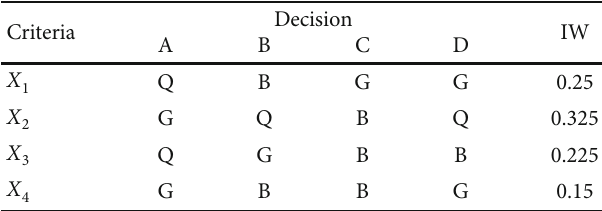
Table 4: The importance weights of the four